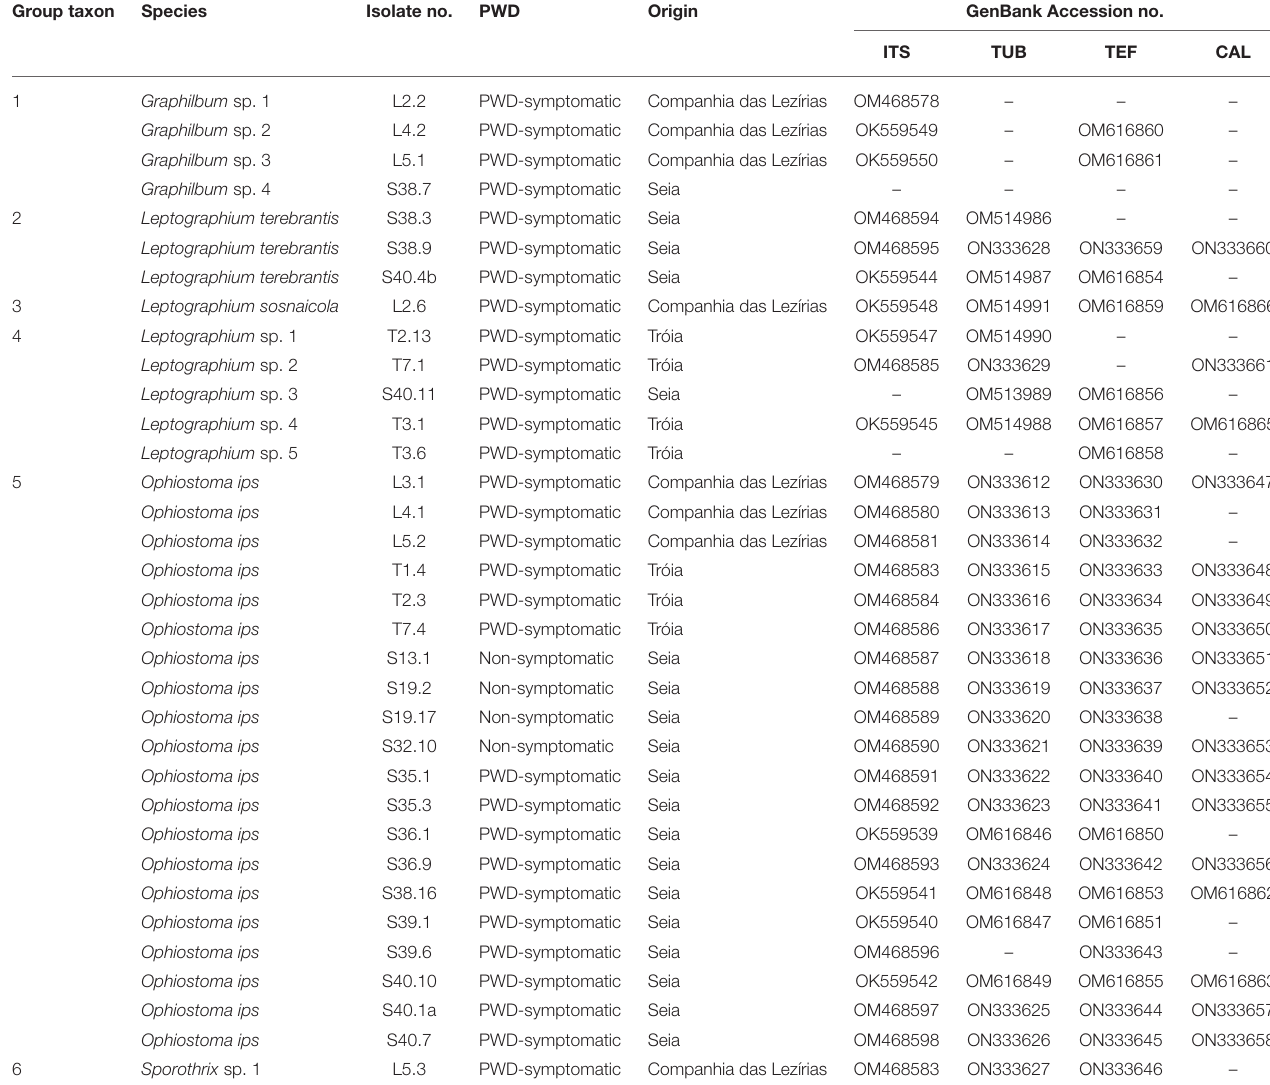
TABLE 3 | Fungal isolates representative of the main Ophiostomatales genus isolated in this study. Group